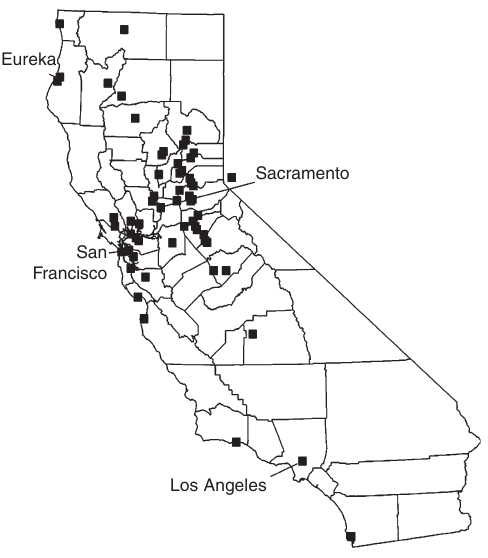
Fig. 2a. Locations of newspapers in print, 1850-